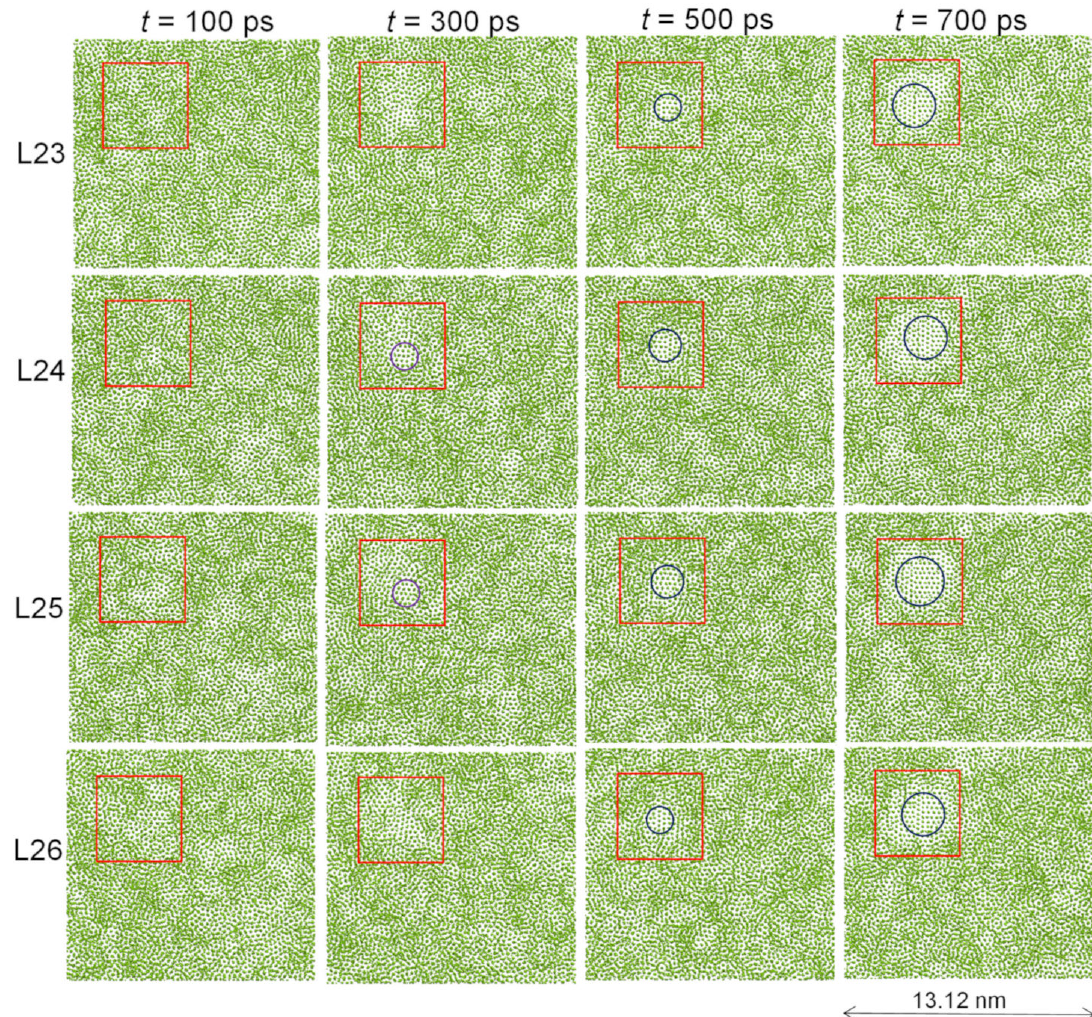
Figure 18. Nucleation becomes homogeneous when the amorphous substrate surface is rough. Time-averaged atomic positions in the relevant atomic layers (L0 denotes the substrate) showing the evolution of a solid cluster formed homogeneously in the bulk liquid far away from the L/N interface at an undercooling of ∆ T n = 433 K. The amorphous substrate with rough surface was created by quenching the liquid from 900 K (denoted as 3D amorphous). A nucleus of r * = 0.65 nm (marked with purple circles) was formed around L25 at t = 300 ps and then grows with time (marked with blue circles). The red squares mark the area where nucleation